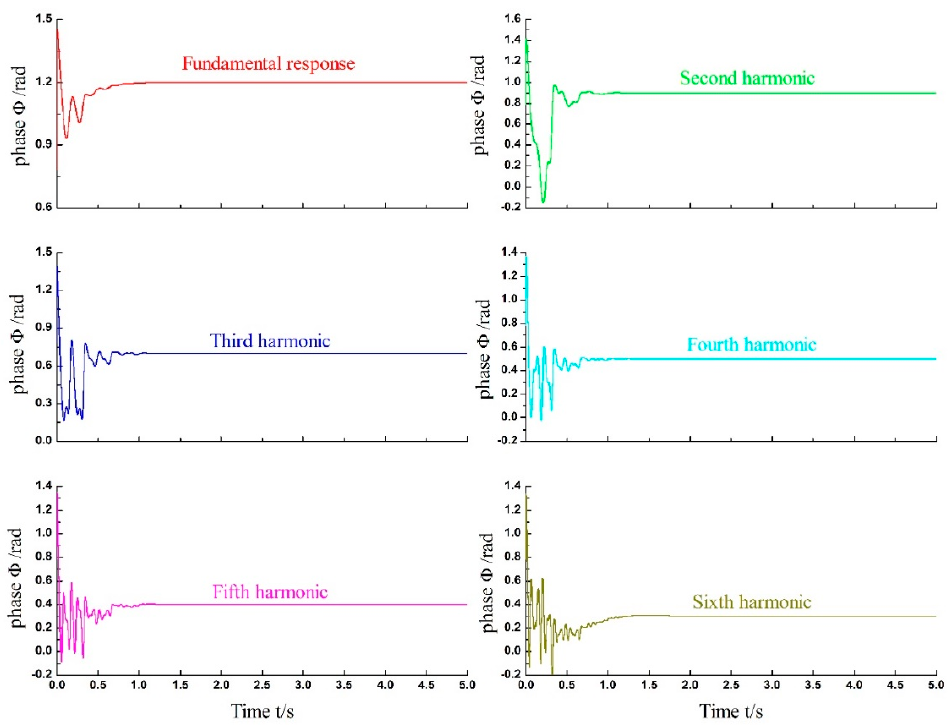
Figure 9. Estimation phases of simulation results.